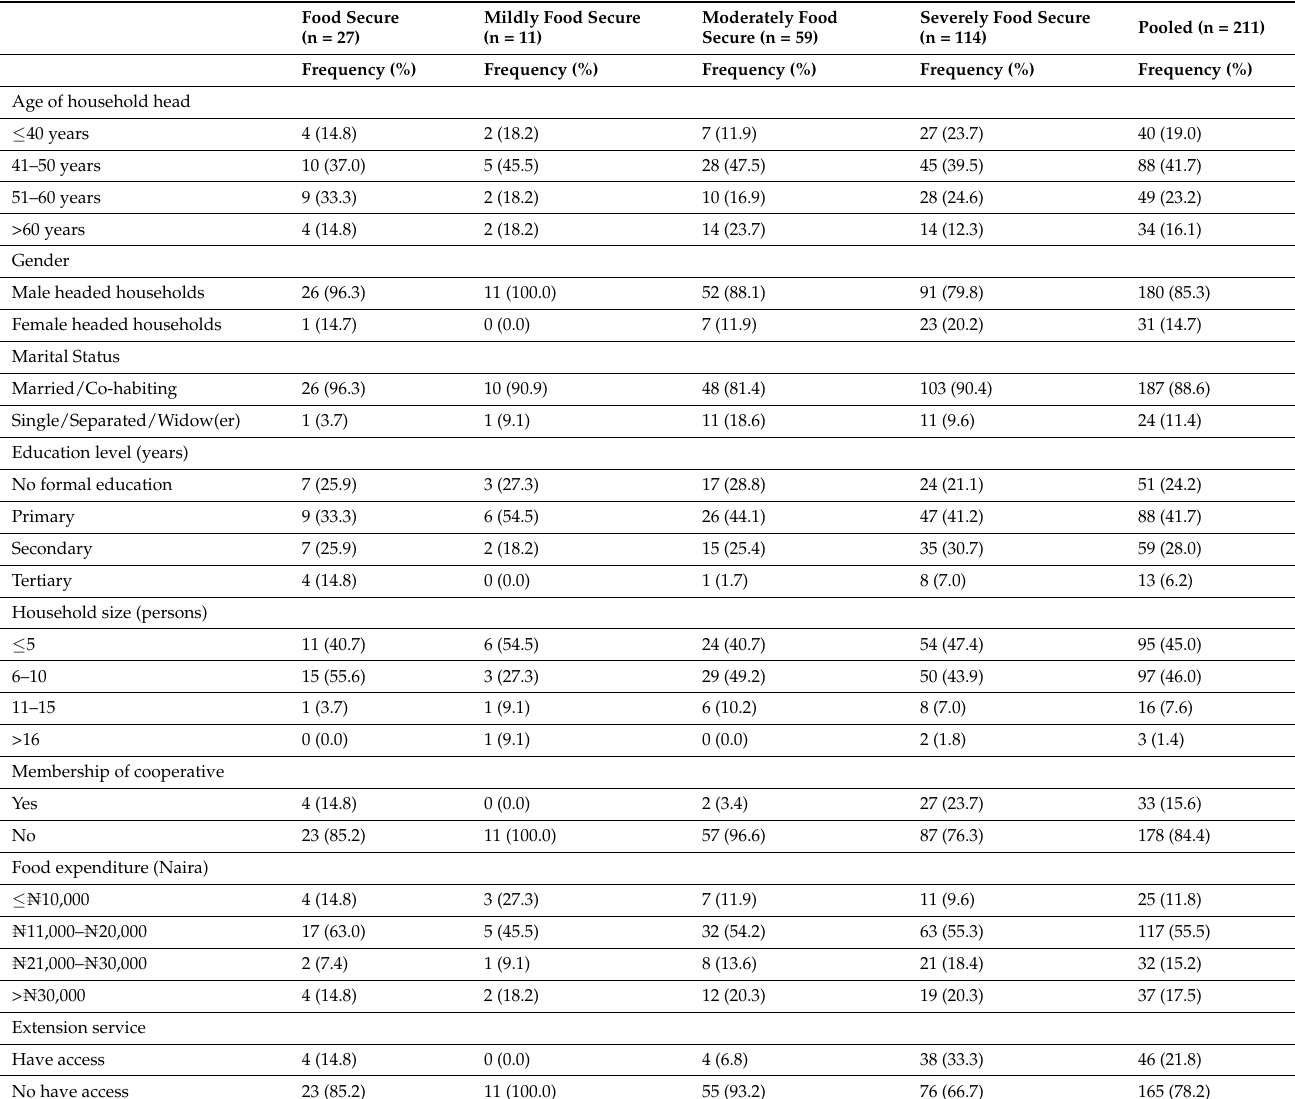
Table 6. Distribution of socio-demographic characteristics of cassava farming households according to food insecurity category. Food Secure (n =